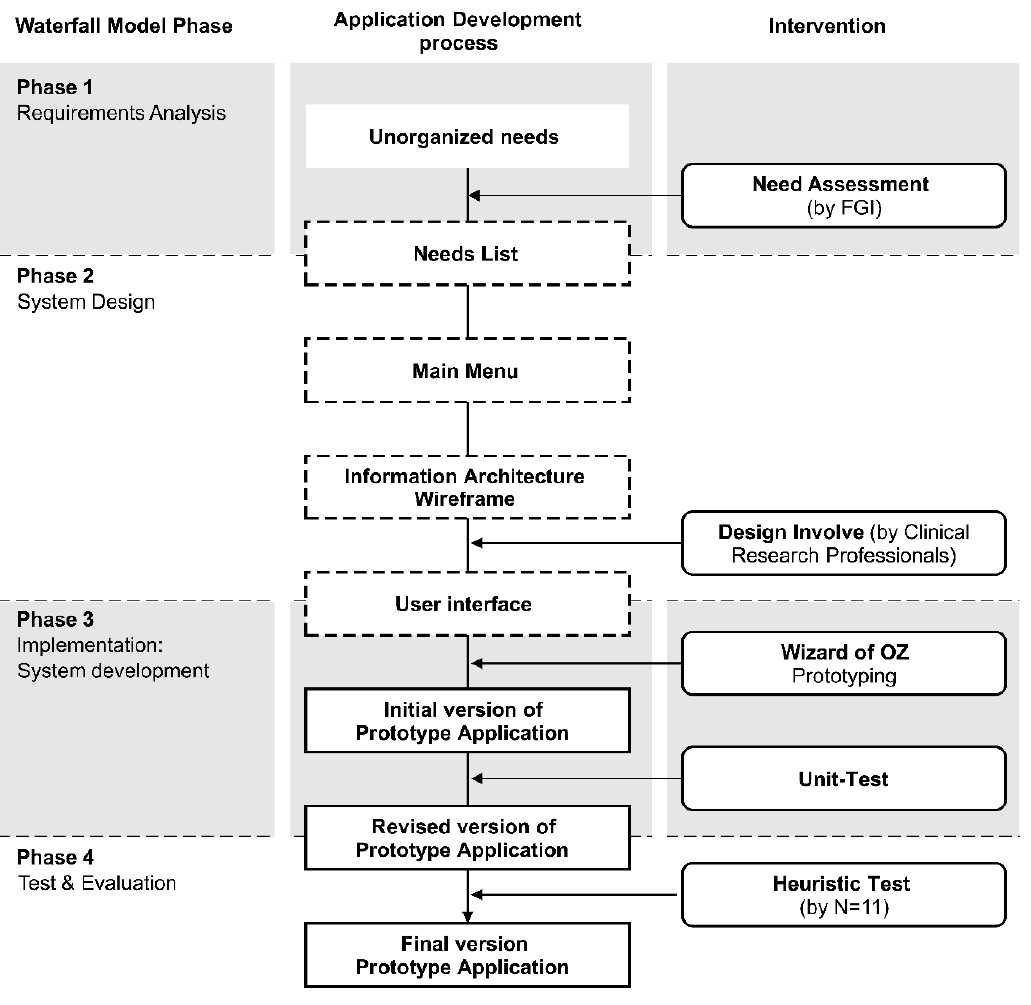
Figure 1. Study flow diagram. FGI, focus group interview.